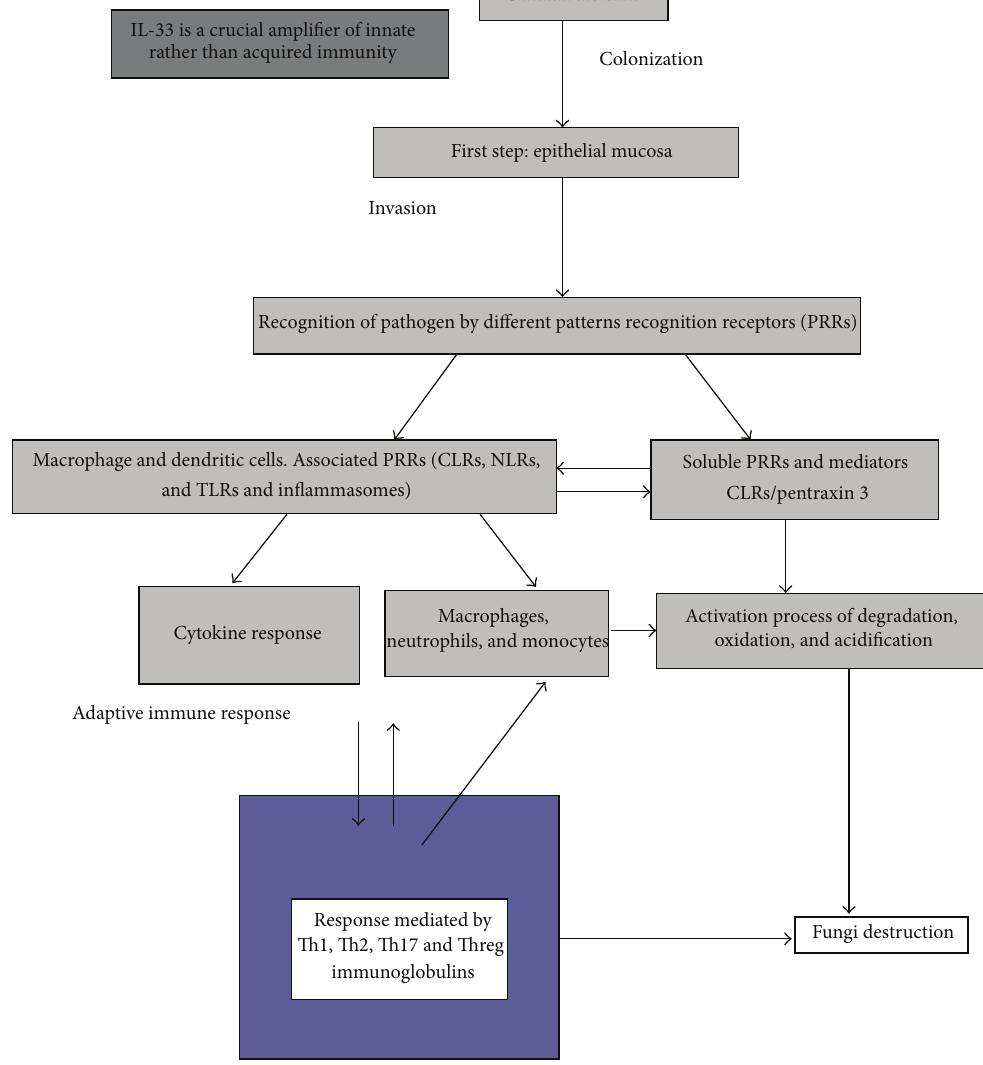
Figure 1: Pathways of host immune responseto Candida colonization. CLRs,NLRs, and TLRs. CLRs(C-typelectin receptors); NLRs (NODE- like receptors); and TLRs (toll-like receptors) (modified from